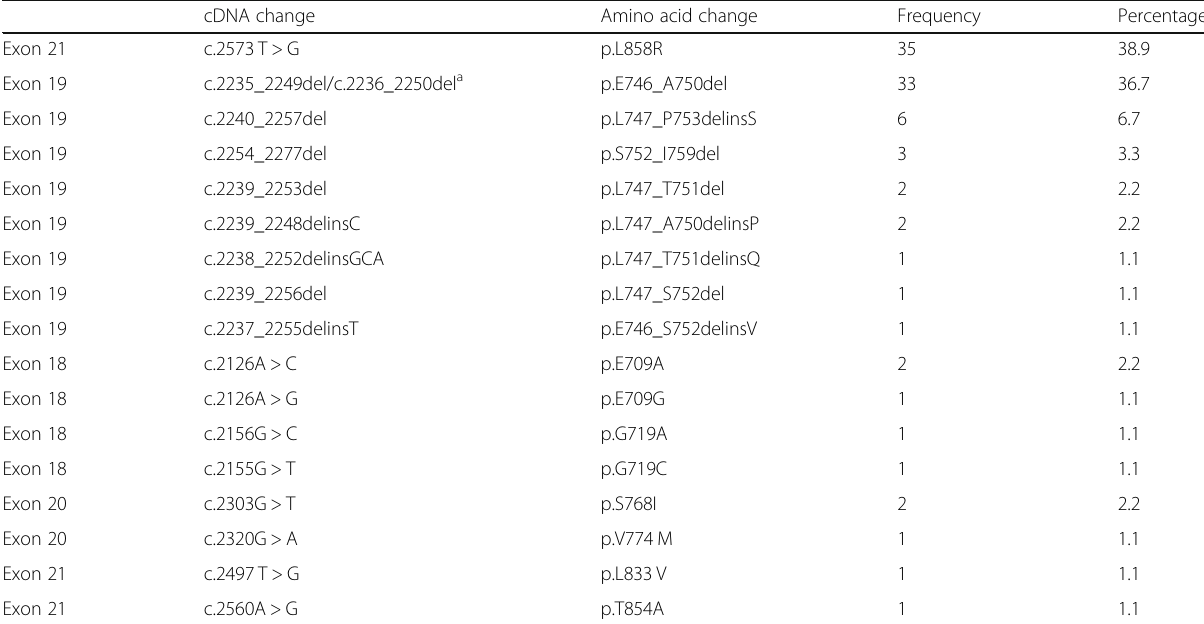
Table 2 EGFR mutations in 90 lung cancers cDNA change Amino acid